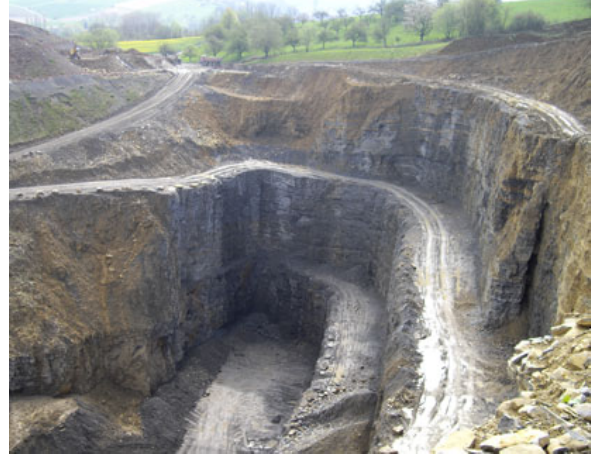
Figure 1: Limestone pit near